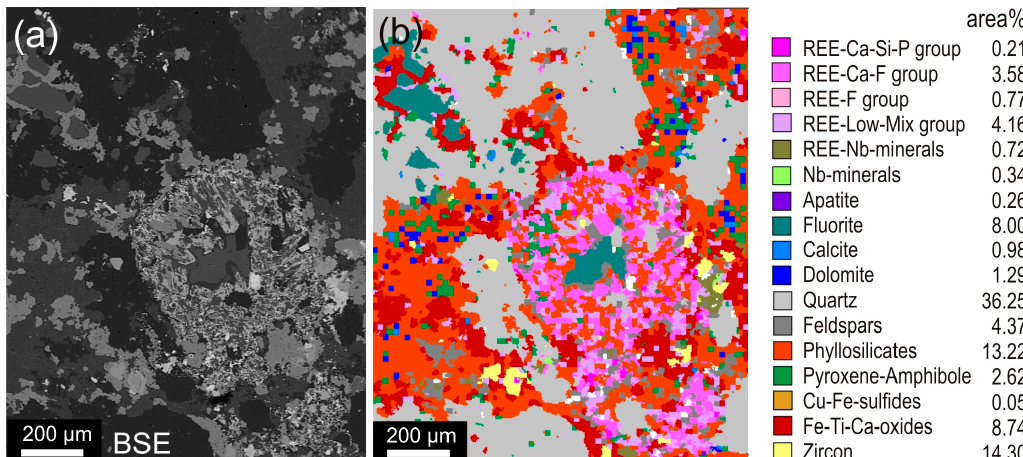
Figure 2. ( a ) Backscattered electron image (BSE) of one frame (magnification 175 times) of an automated scanning electron microscopy-mineral liberation analysis (SEM-MLA) measurement of a polished thin section from a hydrothermally overprinted alkali plutonite. A complete measurement of the 25 × 40 mm sized thin section is composed of ~300 frames. The BSE image displays only a comparably low resolution due to technical reason. ( b ) Classified, grouped and color-coded presentation of the frame in (a) in an automated SEM-MLA measurement in the GXMAP routine; the modes in the mineral legend are in area percent and are related to the whole sample area. Stepsize is 18 µ m. The images in (a) and (b) display fine-grained and heterogeneously composed parts and REE mineral grains in intimate intergrowth with phyllosilicates and